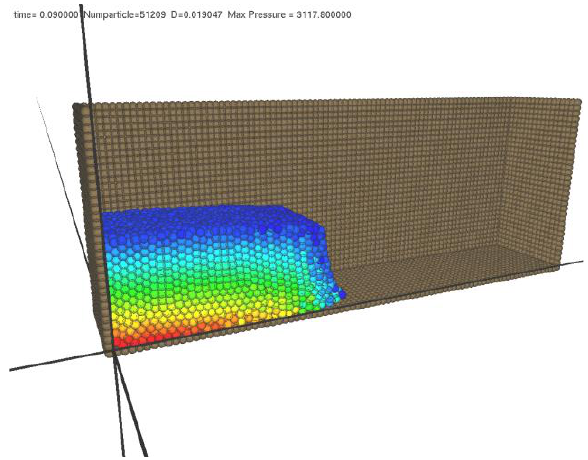
Fig. 13(a). Bird's eye view of dam break simulation (t = 0.09 sec.)